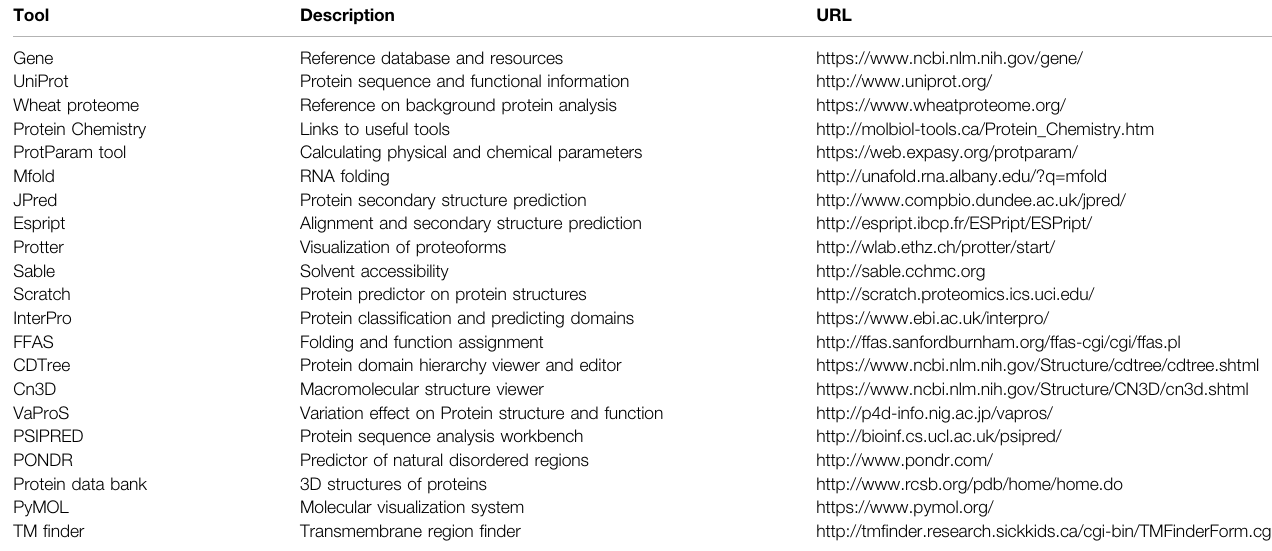
TABLE 1 | Protein analysis tools and selected